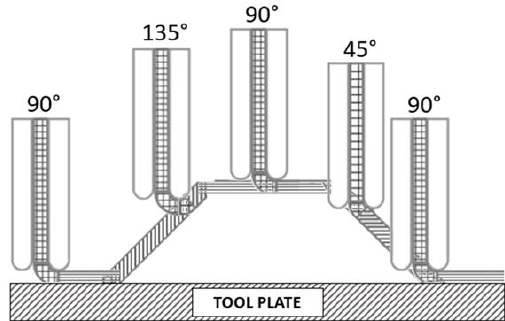
Figure 11. Tow-nozzle exit angle variation.